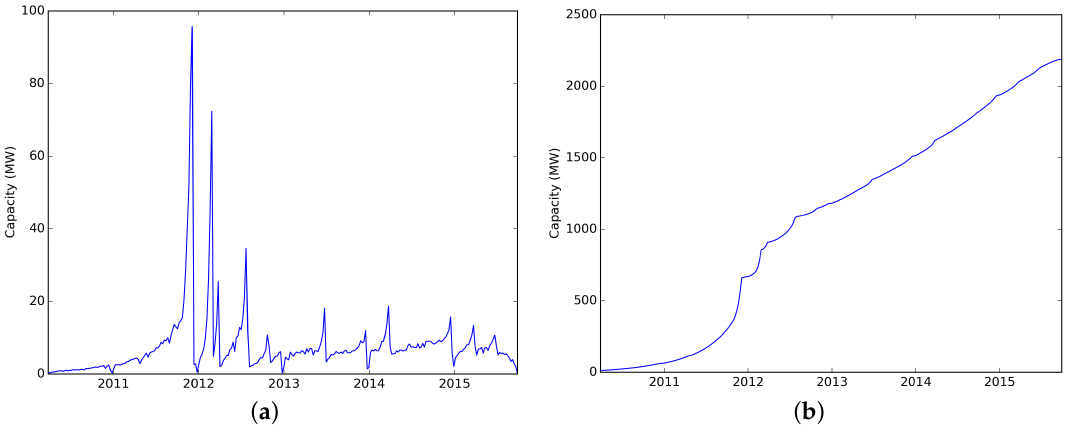
Figure 3. Temporal distribution of domestic PV installations under the feed-in tariff incentive. ( a ) Domestic PV capacity commissioned per week; ( b ) Cumulative domestic PV capacity commissioned.